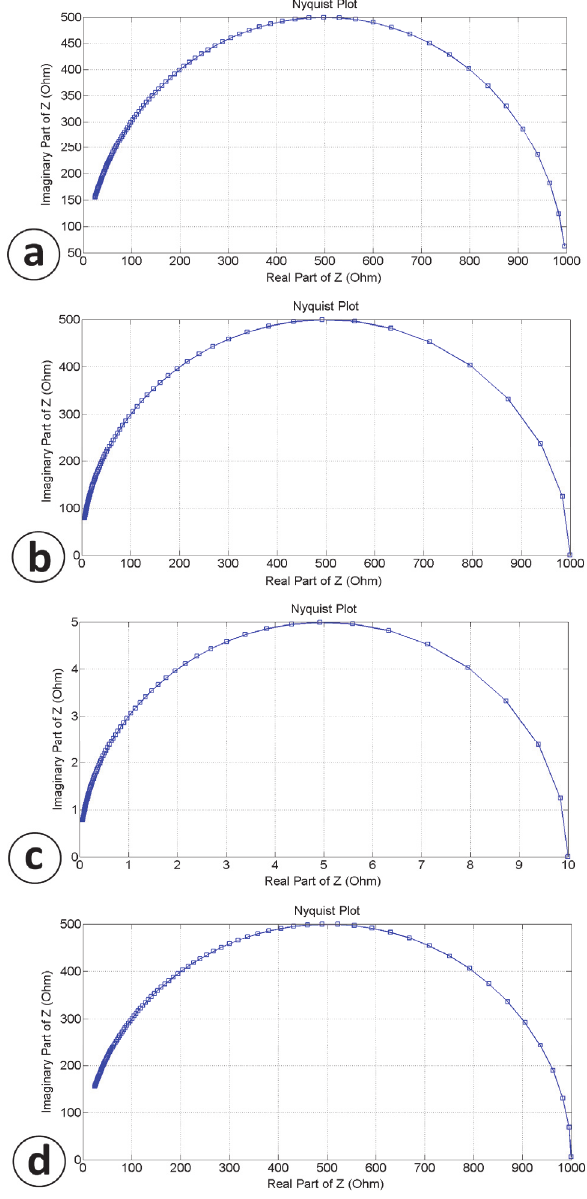
Fig.10: Nyquist plots obtained from computer simulations on CCM in the Matlab-based impedance data